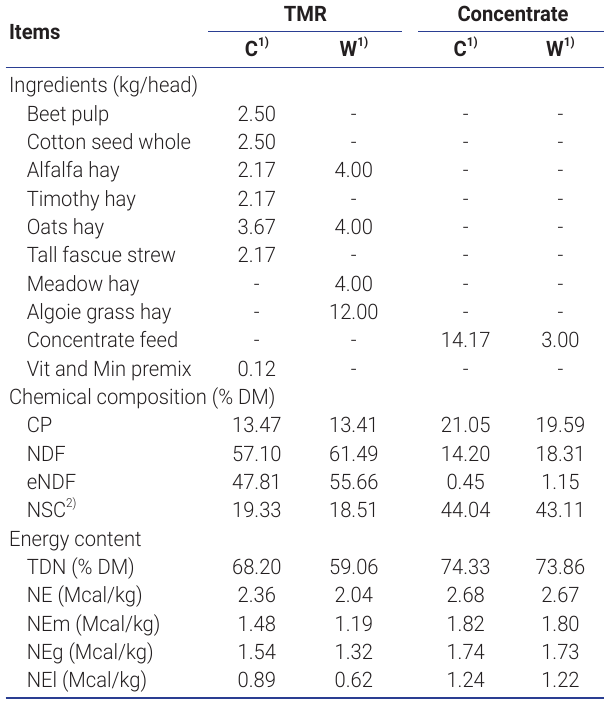
Table 1. Chemical composition of the diet on the conventional and welfare farms